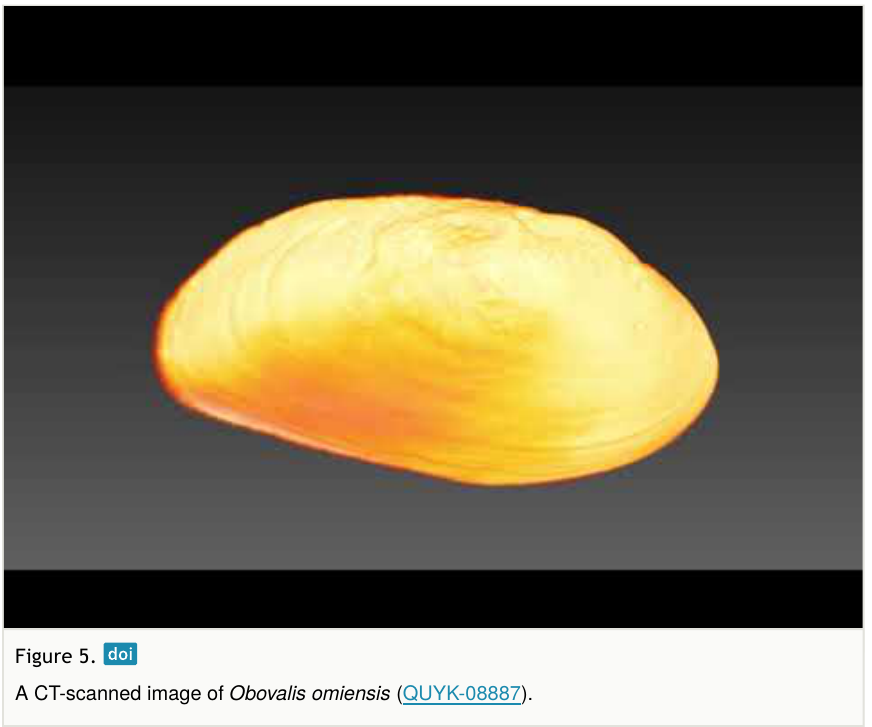
mtDNA analysis of 16S-rRNA was conducted for 31 individuals (Fig. 6). For PCR ampli fi cation, we used the primer pair Unio16SFwd (forward: 5 ′ - TGCCTGTTTACCAAAAACATCG-3 ′ ) and Unio16SRev (reverse: 5 ′ - CTTGGGGTCCTTTCGTACA-3 ′ ). PCR ampli fi cation was performed in 10-µl